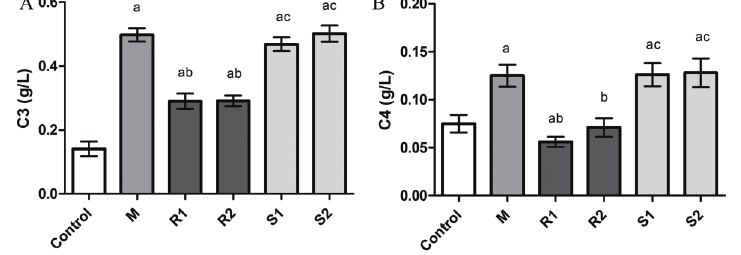
Figure 2. Concentrations of IgG ( A ), IgM ( B ) and IgA ( C ). M: intestinal obstruction group; R1: 2-day natural recovery group; R2: 4-day natural recovery group; S1: 2-day Sijunzi treated group; S2: 4-day Sijunzi treated group. Data are reported as means ± SD. a P o 0.05 compared to normal control group; b P o 0.05 compared to M; c P o 0.05 compared to R1 and R2 (ANOVA).